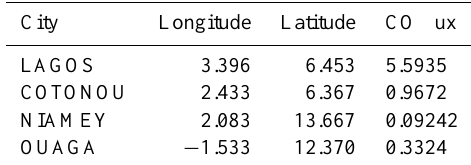
Table 1. CO fluxes in µgm − 2 s − 1 for the 0.5 × 0.5 ◦ grid cell con- taining each of the 4 West African cities where aircraft data are available. Data are from the RETRO inventory (see http://retro.